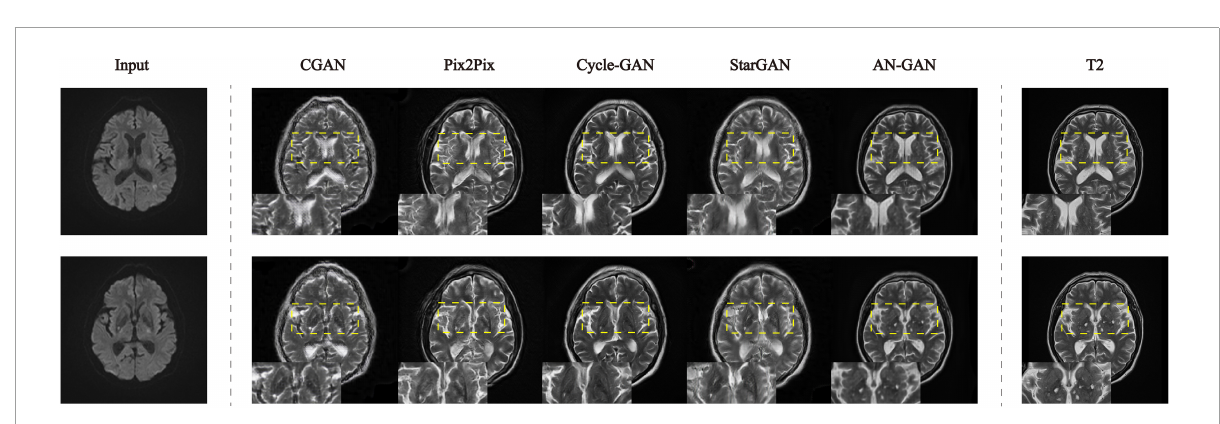
FIGURE8 Experimental results of CGAN, pix2pix, Cycle-GAN, StarGAN, and AN-GAN in the test set. Synthesis of images from DWI to T2.